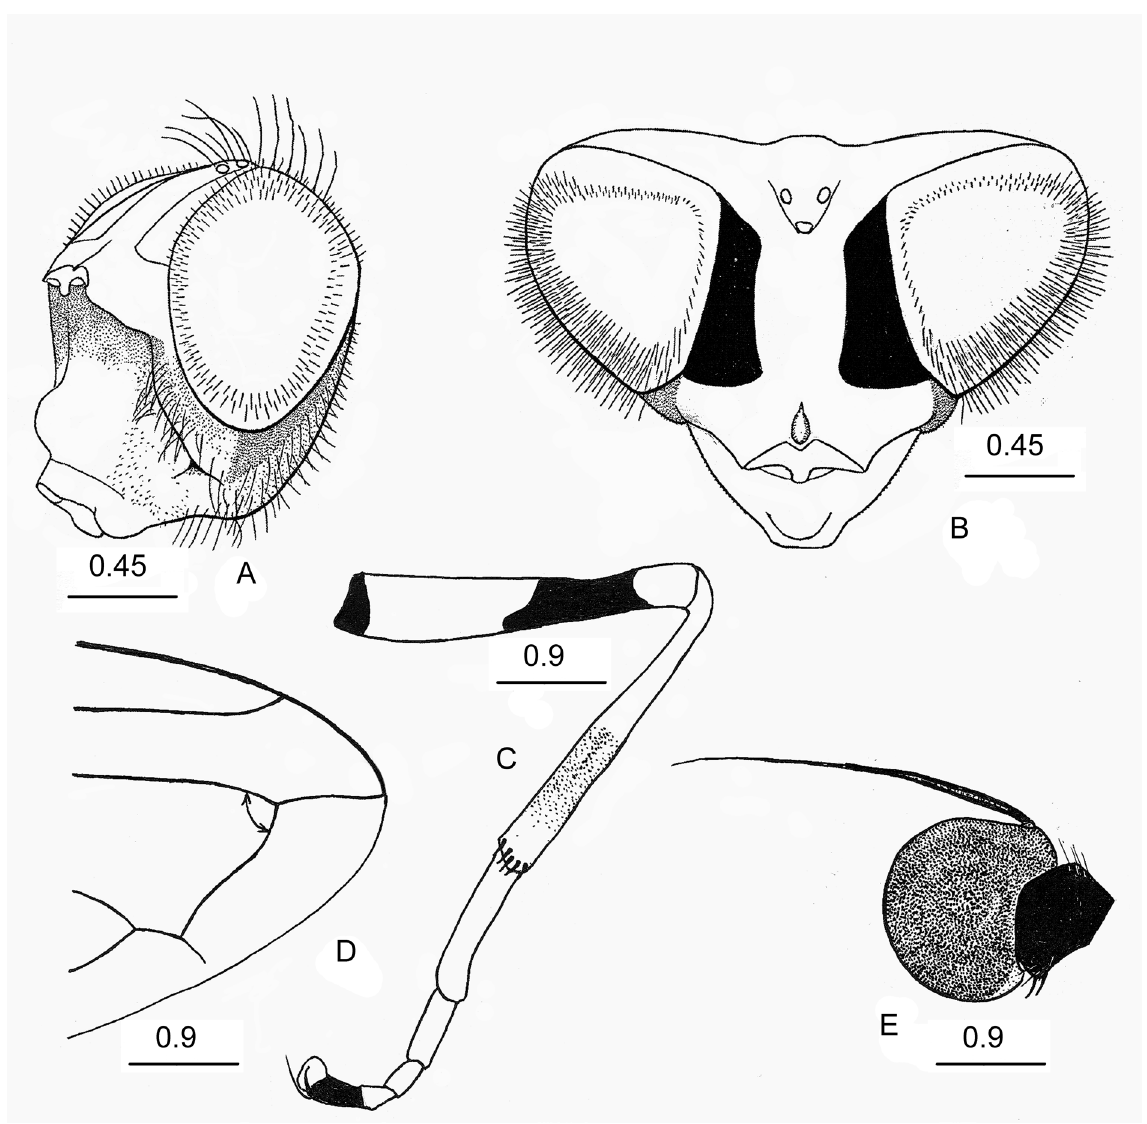
Fig. 34. Cheilosia insolita sp. nov., holotype, ♀ (CNC). A . Head, anterior view. B . Head, dorsal view. C . Mid leg, anterior view. D . Tip of wing. E . Antenna, lateral view of pedicel and basoflagellomere. Scale bars indicated in